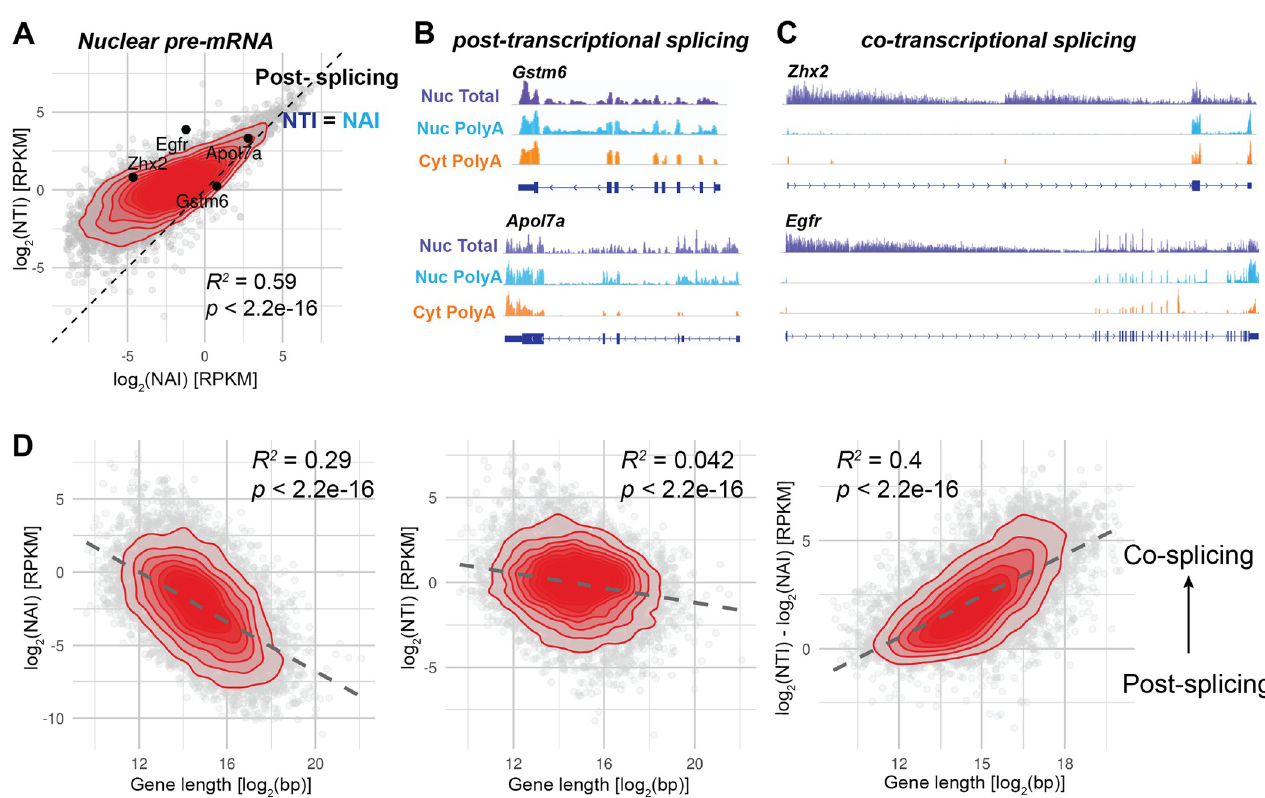
Fig 3. The extent of co- versus post-transcriptional splicing increases with gene length. A : Comparison of pre-mRNA expression levels in Poly(A) et Total nuclear RNA populations of protein coding transcripts (grouped by biotype): log 2 (NTI) against log 2 (NAI). Transcripts on the identity line (NAI = NTI, dashed line) are not spliced co-transcriptionally, while those away from the line are. Genes whose genome track are shown in B and C are shown on the plot. Red: 2D kernel density. Only protein coding transcripts are shown. B : Genome track view of short genes that are mainly post-transcriptionally spliced. Gene length of Gstm6 : 4.9kb, Apol7a : 11kb. C : Genome track view of long genes that are mainly co-transcriptionally spliced. Gene length of Zhx2 : 145kb, Egfr : 166 kb. Genome tracks are not to scale. D : Correlations of the gene length (exon + intron) with log 2 (NAI), log 2 (NTI) and log 2 (NTI/NAI). The latter is related to the fraction of co- and post-transcriptional splicing. Overall, long genes are more frequently co-transcriptionally spliced than short genes.